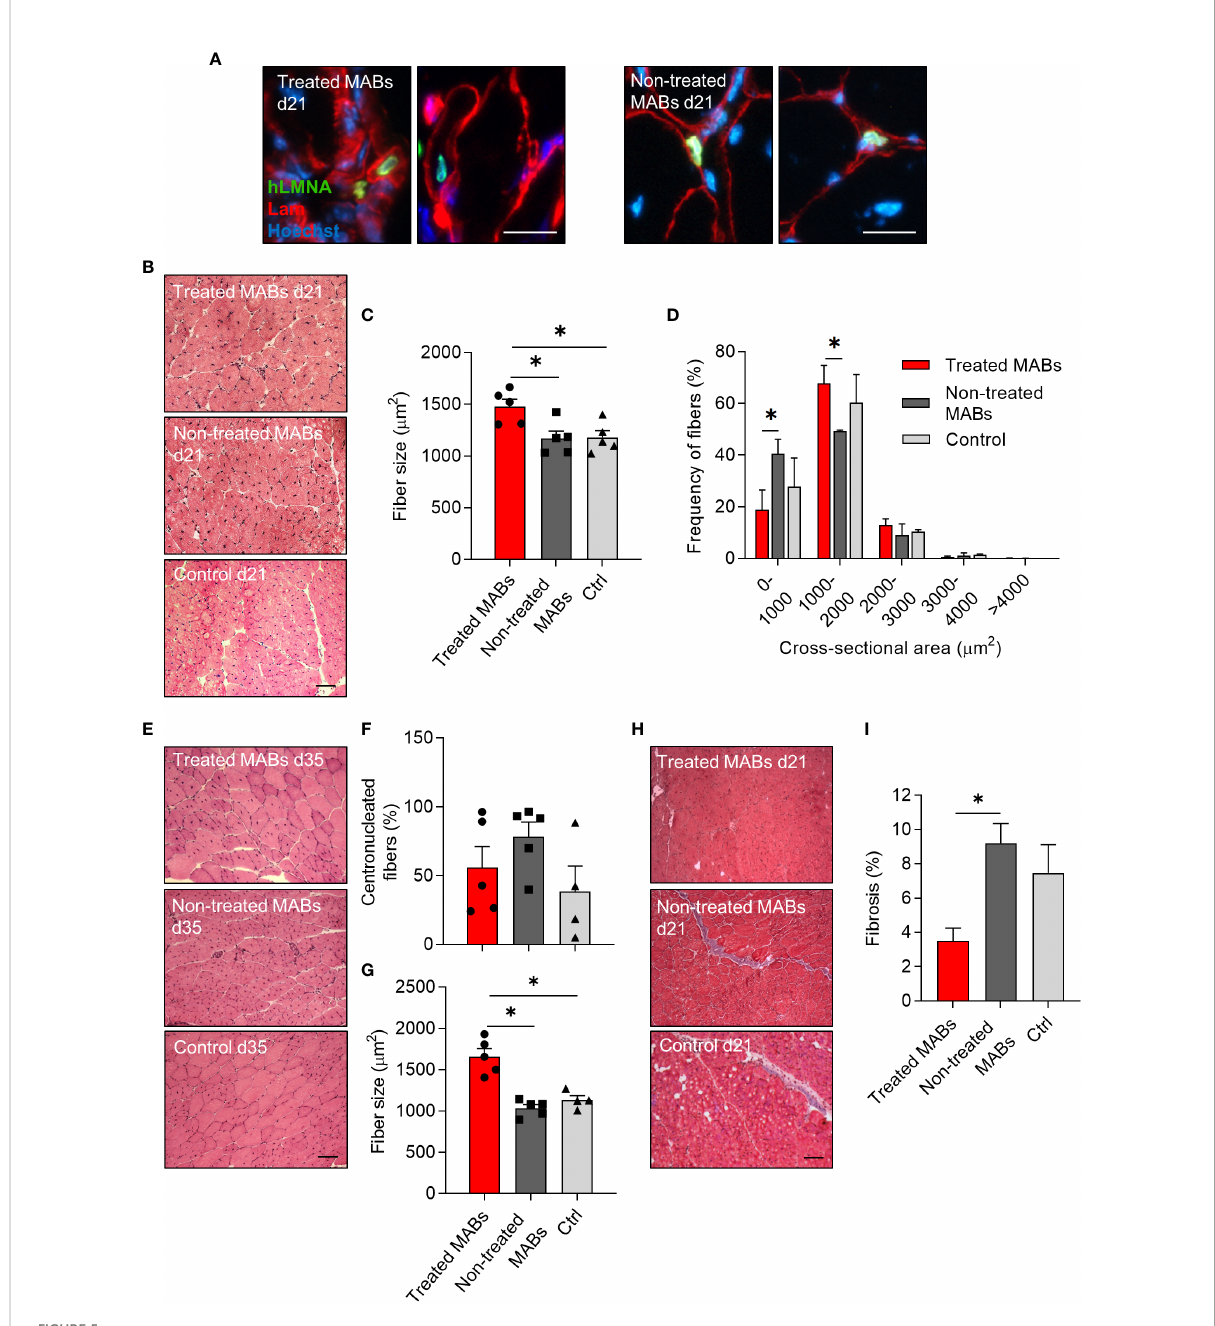
FIGURE 5 Histological analysis of aged muscles after acute injury and cell transplantation of microRNA-treated and non-treated human mesoangioblasts. (A) Localization of human mesoangioblasts (hMABs) in the injected skeletal muscle at day 21 after cell transplantation. Immuno fl uorescence analysis for laminin (red) and lamin A/C (green). Hoechst was counterstained in blue. Scale bars: 25 µm. (B) Representative images of haematoxylin and eosin staining in transplanted muscles with microRNA-treated hMABs, non-treated hMABs, and cardiotoxin control at day 21 (d21). Scale bars: 100 µm. (C) Quanti fi cation of fi ber size (mean cross-sectional area (CSA)) at day 21. (D) Quantitative frequency distribution analysis of the cross-sectional area of fi bers at day 21. (E) Representative images of haematoxylin and eosin staining in transplanted muscles with microRNA-treated hMABs, non-treated hMABs, and cardiotoxin control at day 35 (d35). Scale bars: 100 µm. (G) Quanti fi cation of fi ber size (mean CSA) at day 35. (F) Percentage of centronucleated fi bers at day 35. (H, I) Masson ’ s tricrome staining of injected hindlimb muscles at day 21 (d21) and quanti fi cation of area of fi brosis. One-way ANOVA was used, and results are displayed as mean±s.e.m (*p < 0.05, n = 4-5